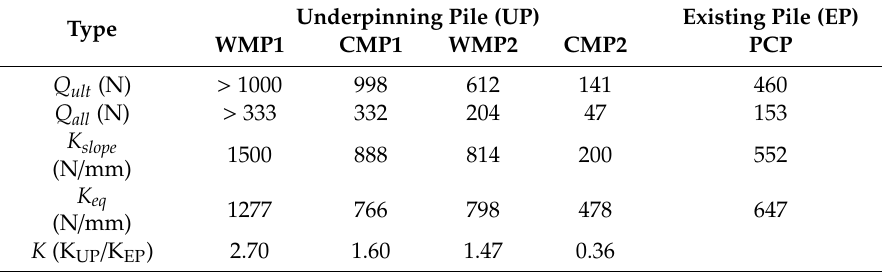
Figure 5. Load settlement behavior of single piles ( s 1 is 0.1D of micropile; s 2 is 0.1D of PCP). Table 2. Bearing capacity and axial stiffness of model piles.